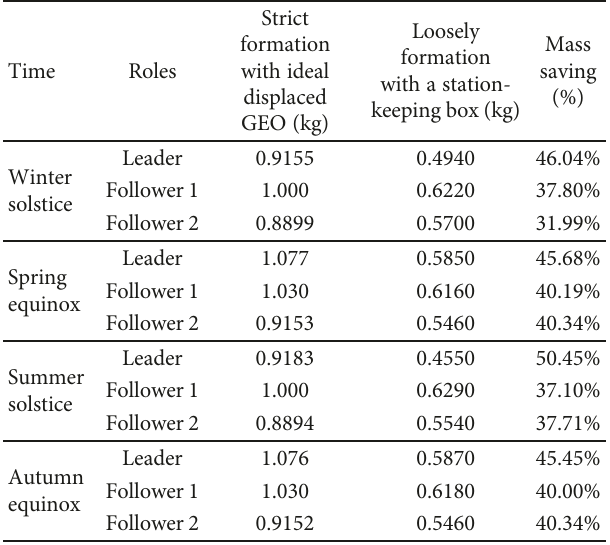
Table 3: Mass consumption for each spacecraft after one day.